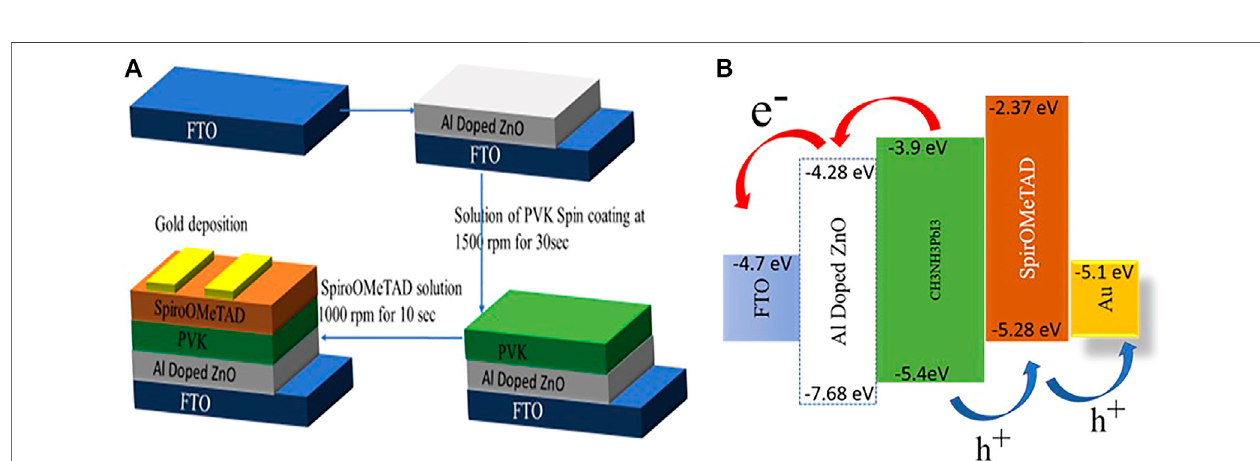
FIGURE 6 | (A) Systematic representation of fabrication of device. (B) Energy band diagram of device.